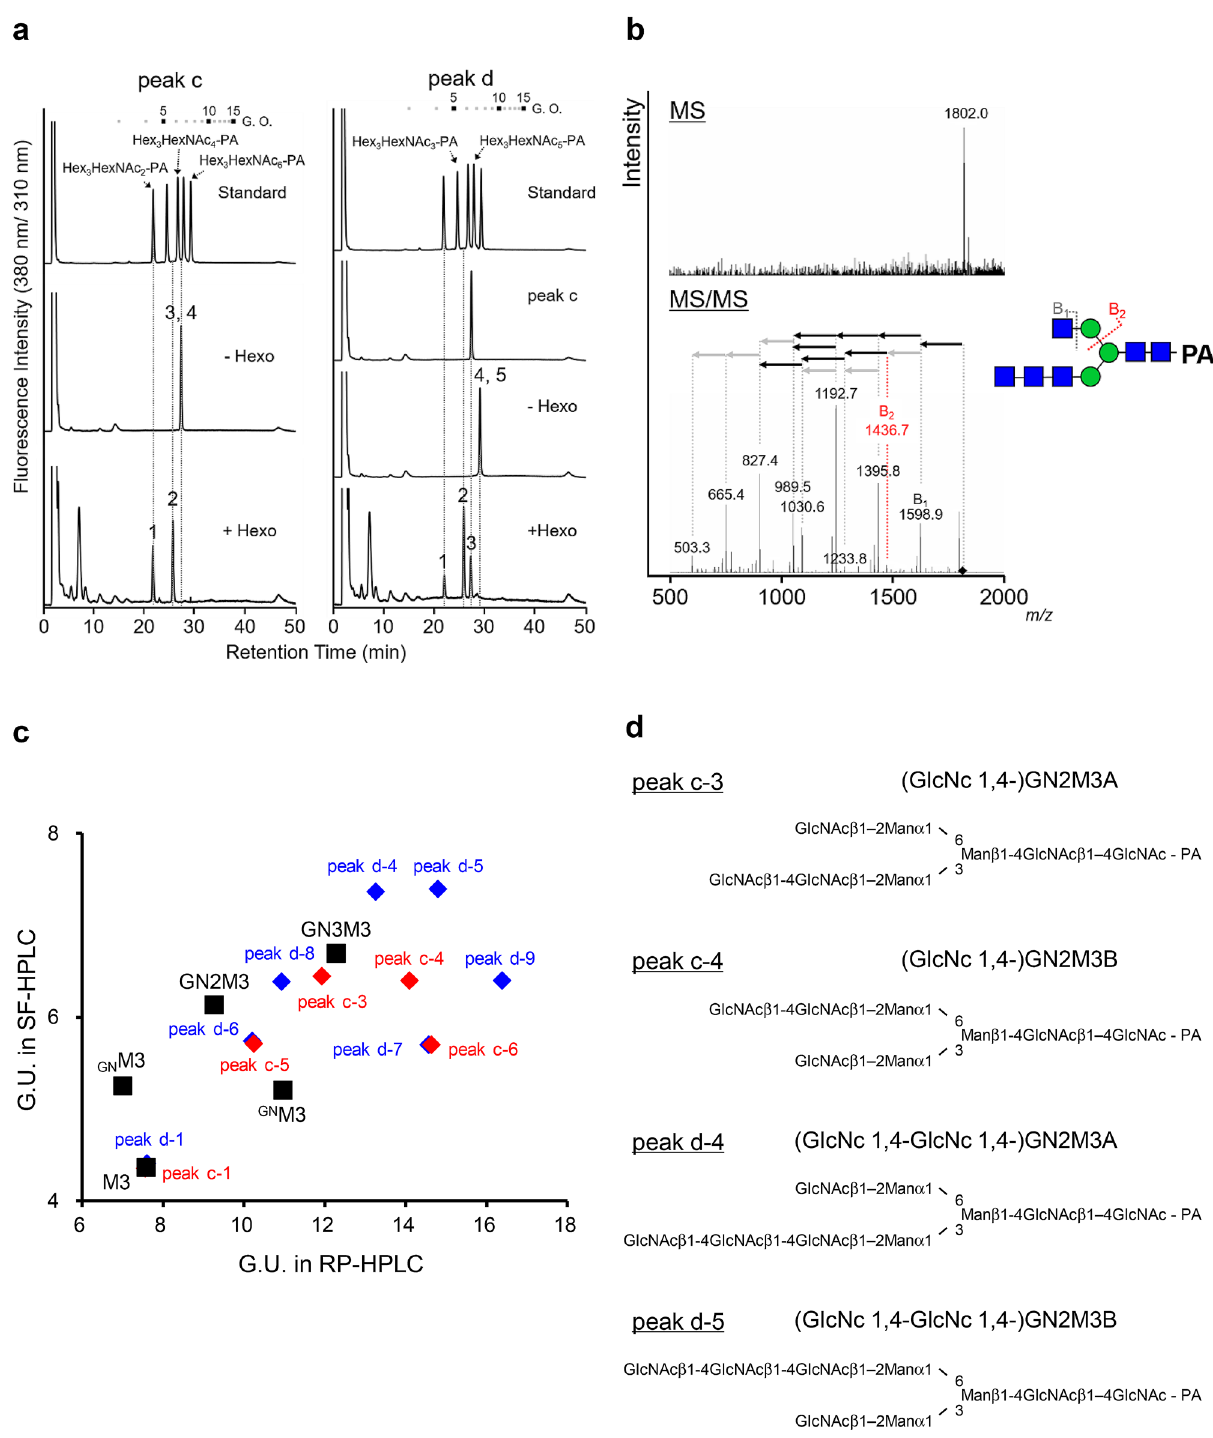
Figure 5. Structural determination of N -acetylglucosaminylated sugar chains. ( a ) SF-HPLC analysis of N -acetylhexosaminidase-digested peaks c and d. ( b ) MS and MS/MS analysis of peak d-4. The putative structure of peak d-4, fragmentation scheme, and diagnostic ions are represented. ( c ) Two-dimensional mapping of peak c, hexosaminidase-digested peak c, peak d, hexosaminidase-digested peak d, and authentic PA-sugar chains. Elution positions were calculated from the glucose unit in RP-HPLC and SF-HPLC. The red diamond, blue diamond, and black box indicate peak c, peak d in Figure, their N -acetylhexosaminidase (HEXO)-digested products, and the authentic PA-sugar chain, respectively. ( d ) Deduced structures of N -acetylglucosaminylated